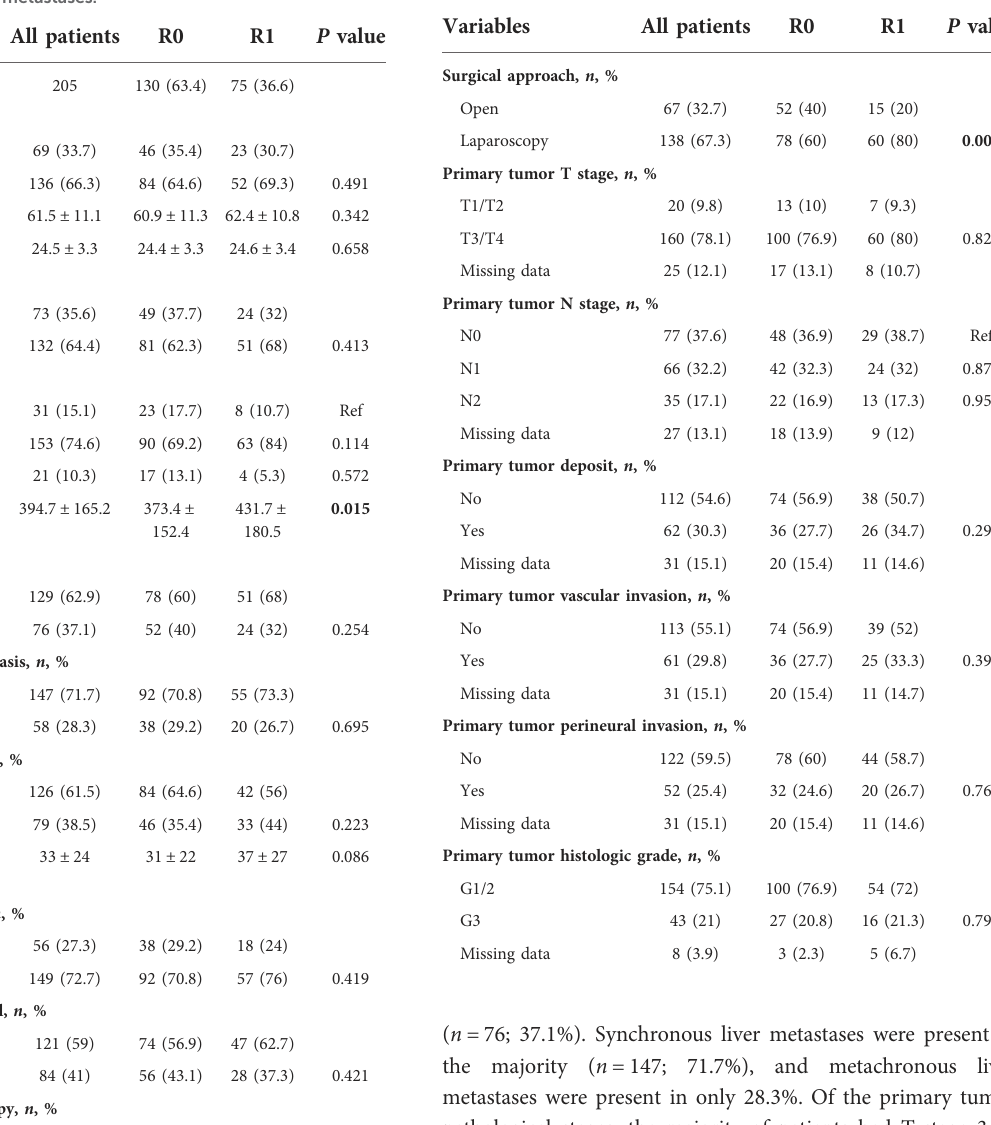
TABLE 1 Demographic and clinical characteristics of 205 patients with colorectal cancer liver